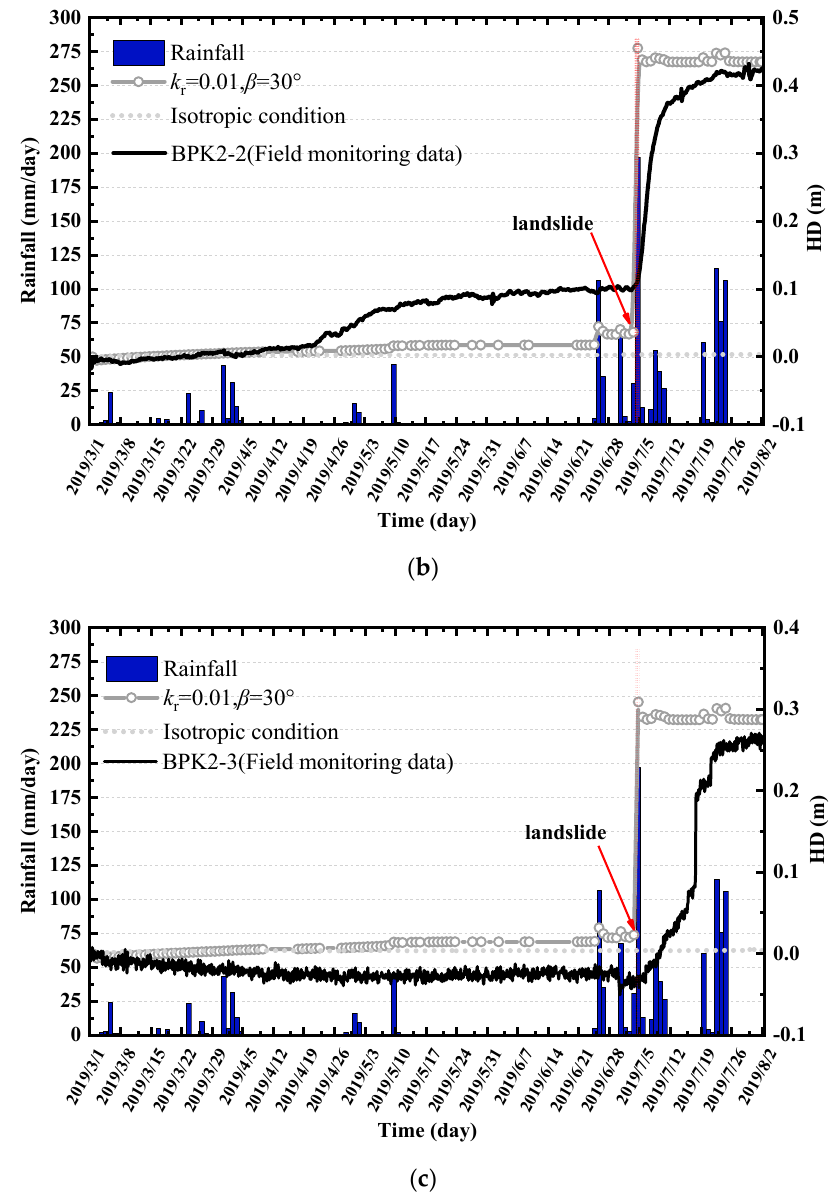
Figure 13. Variations in the horizon displacement of numerical simulation and field monitoring at different monitoring points during rainfall: ( a ) BPK2-1; ( b ) BPK2-2; ( c ) BPK2-3.